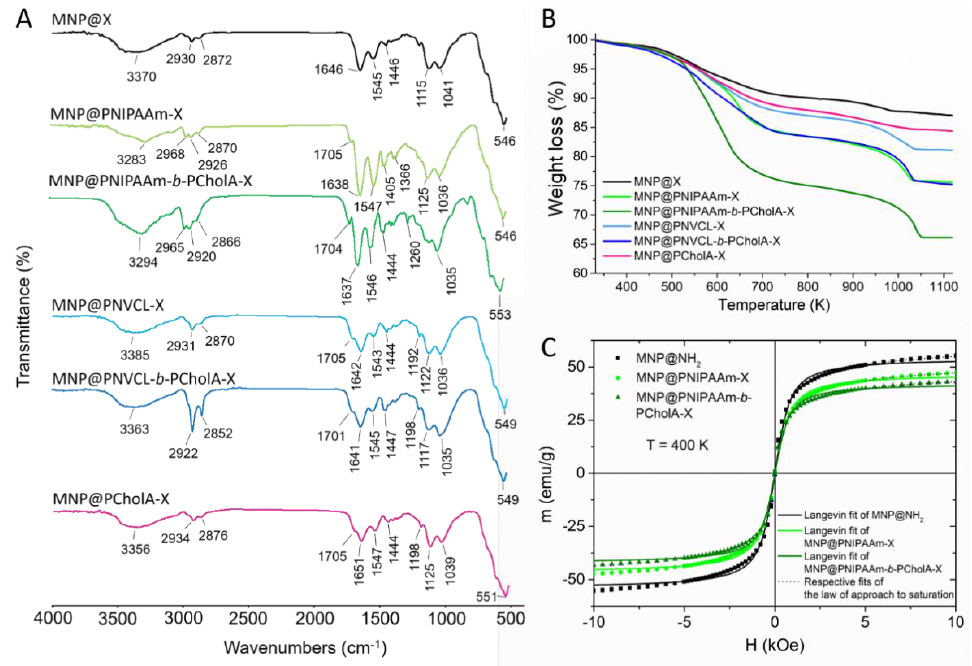
Figure 2. ( A ) FT IR spectra and ( B ) TG curves of the modified iron oxide particles. ( C ) Magnetization of chosen samples at 400 K with fits of Langevin function and law of approach to saturation.